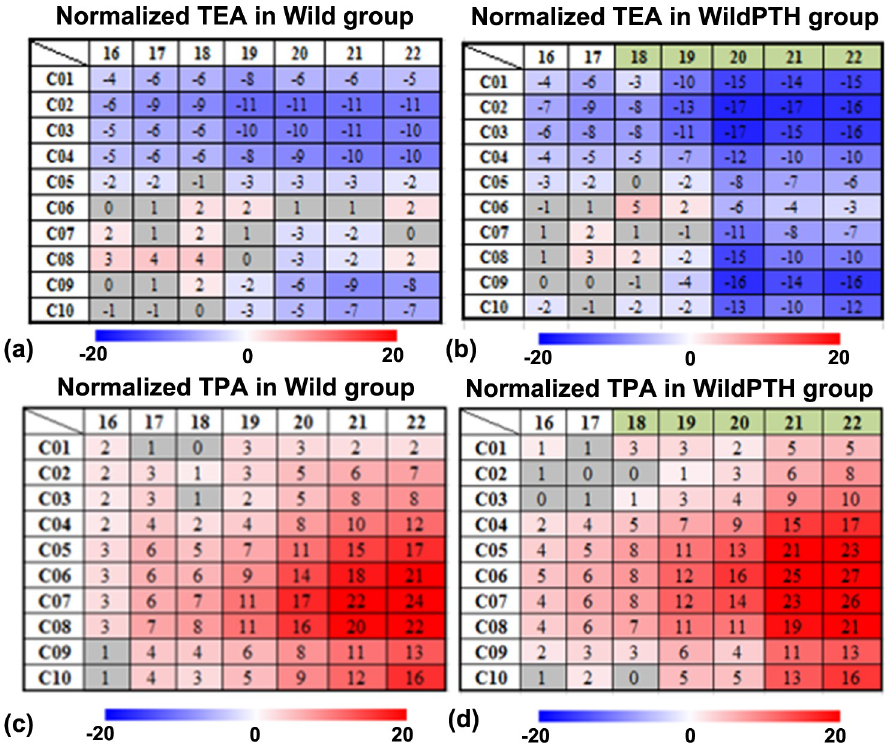
Fig 3. The longitudinal adaptation of the endosteal and periosteal areas (TEA and TPA) of mouse tibiae in the spatiotemporal space in both the Wild and WildPTH groups. The data (units in percentages) are presented as the mean changes normalized with respect to the baseline values at week 14 (intermittent PTH treatment started in week 18 and lasted until week 22, which is labeled in green in the Figure).